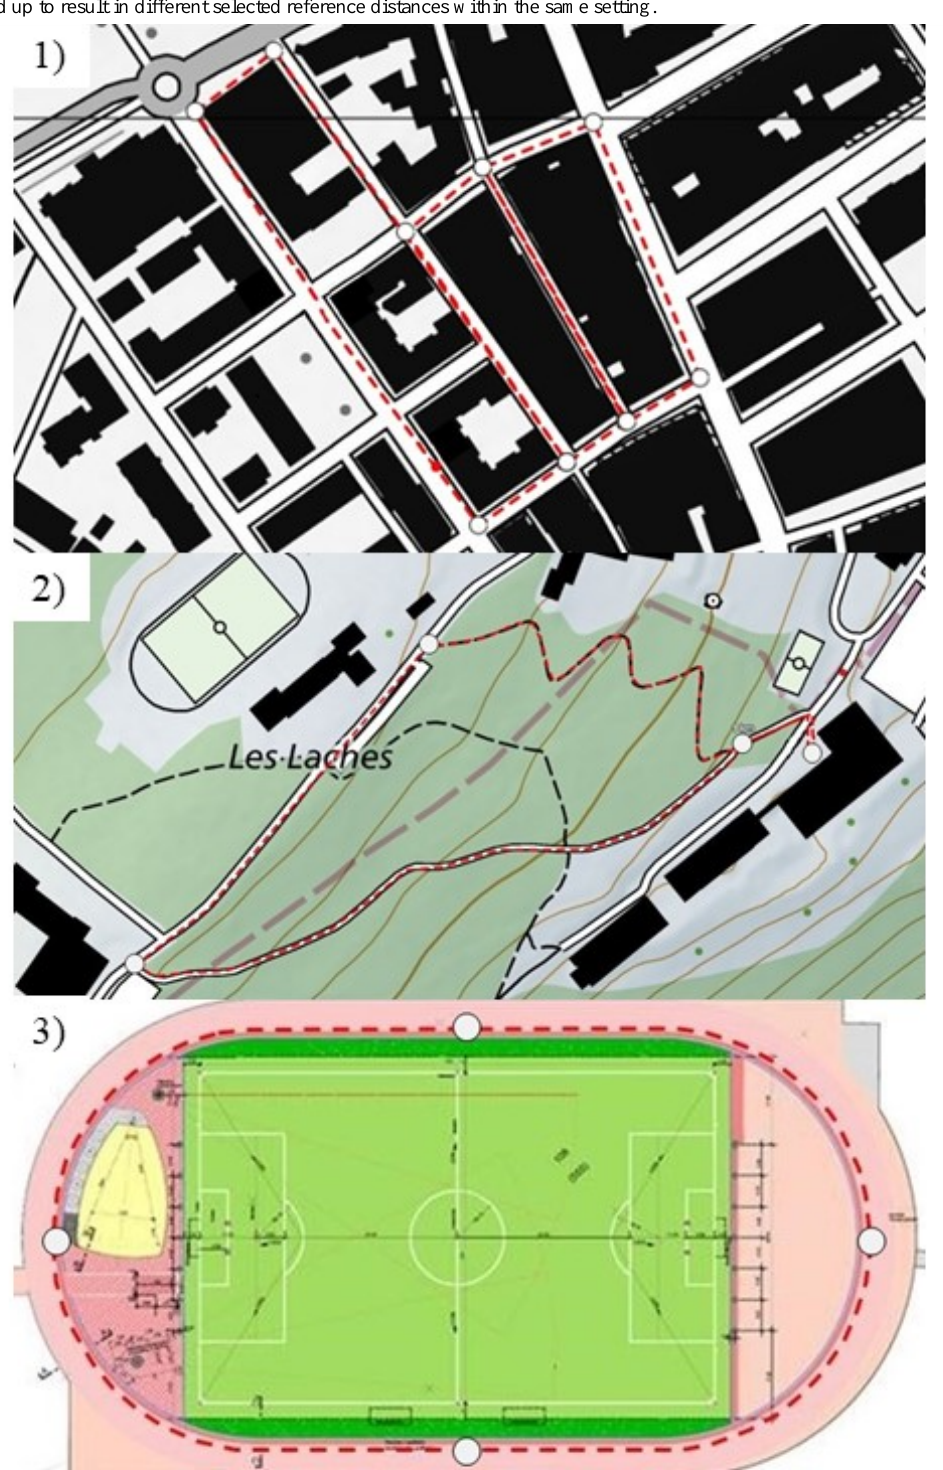
Figure 1. The urban (1), forest (2), and track and field (3) measurement areas. White circles divide the courses into subsections that were randomly combined and added up to result in different selected reference distances within the same